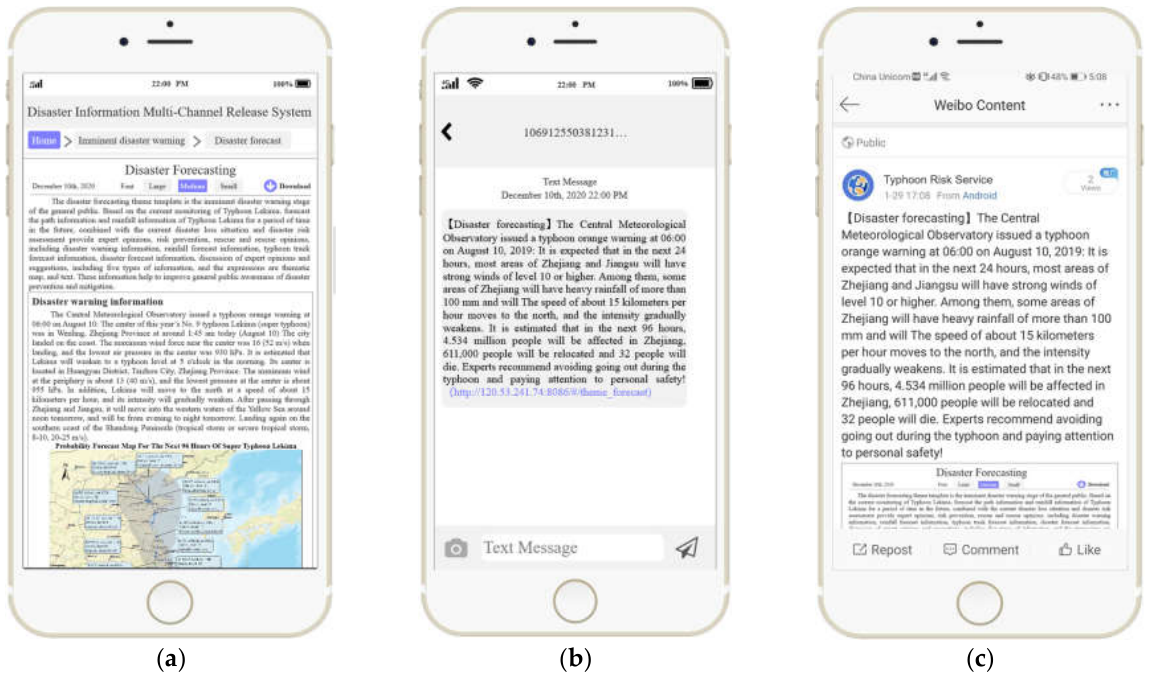
Figure 11. General public interface map. ( a ) APP; ( b ) SMS; ( c ) Microblog.